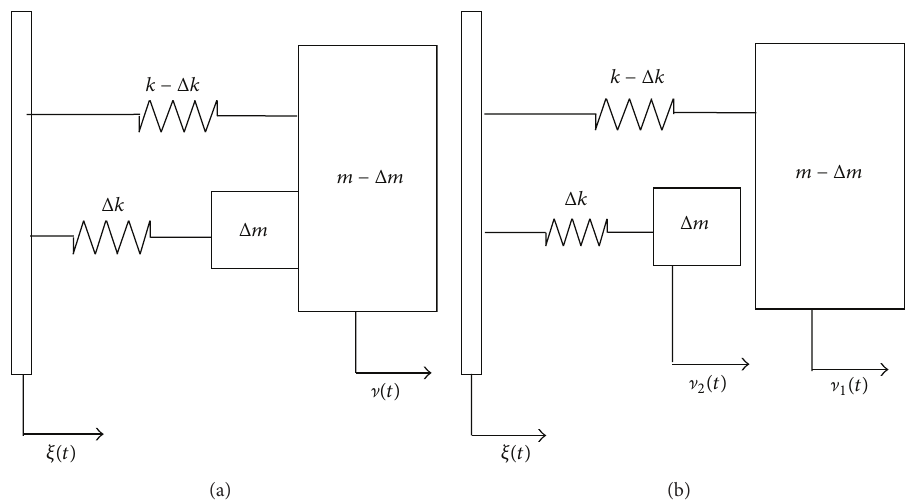
Figure 3: Compound model comprising two single degree-of-freedom models that can oscillate together (a) or independently (b).